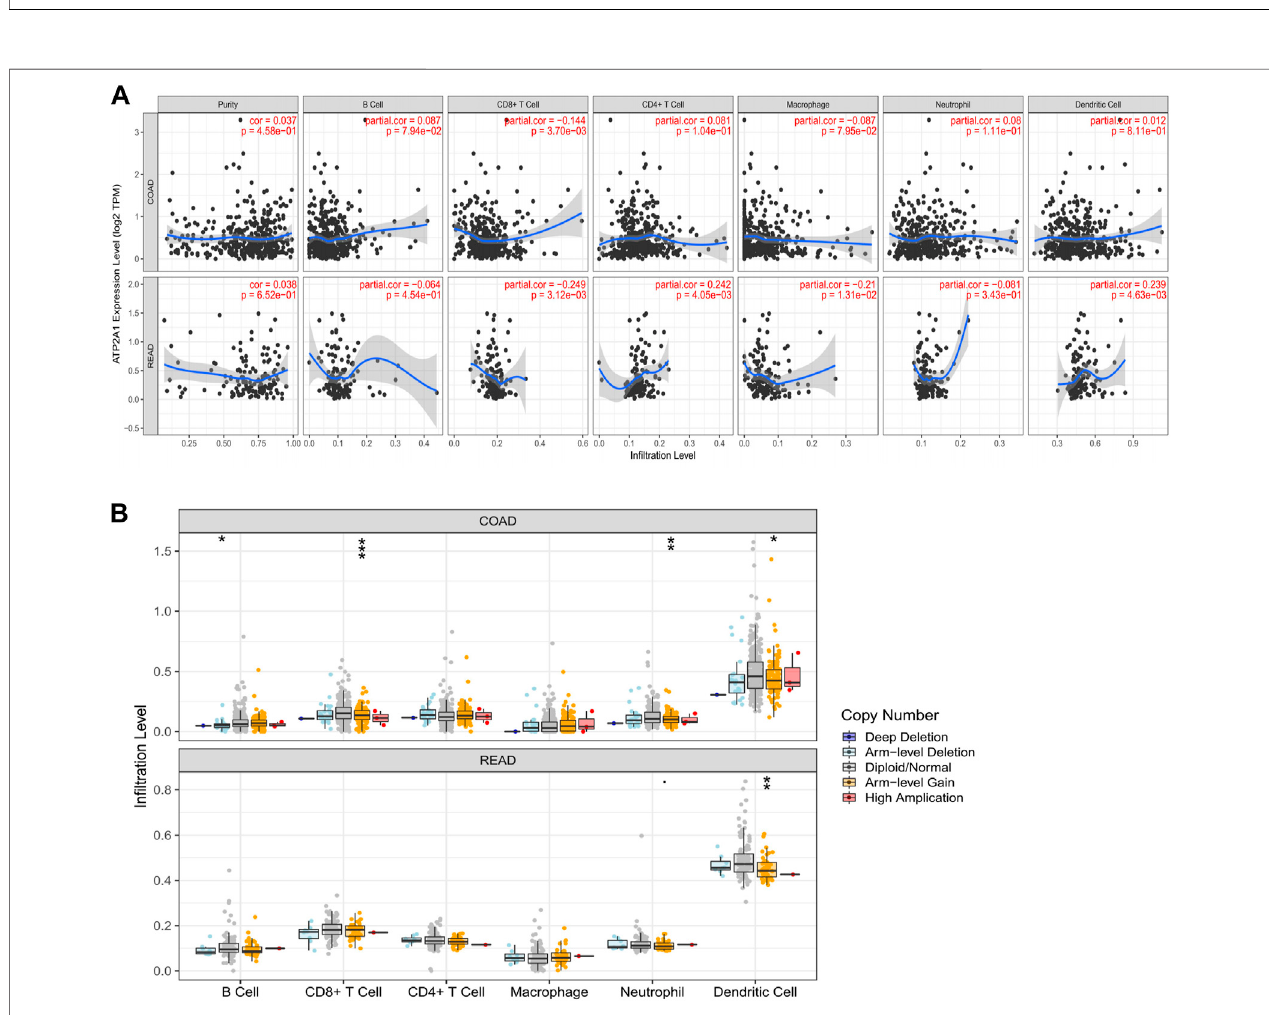
FIGURE 4 | The expression of ATP2A1 was related to immune in fi ltration. (A) The relationship between ATP2A1 mRNA level and the the in fi ltration of six immune cells in COAD and READ. (B) The relationship between copy number variation of ATP2A1 and multiple immune cells. * p < 0.05, ** p < 0.01, *** p < 0.001.